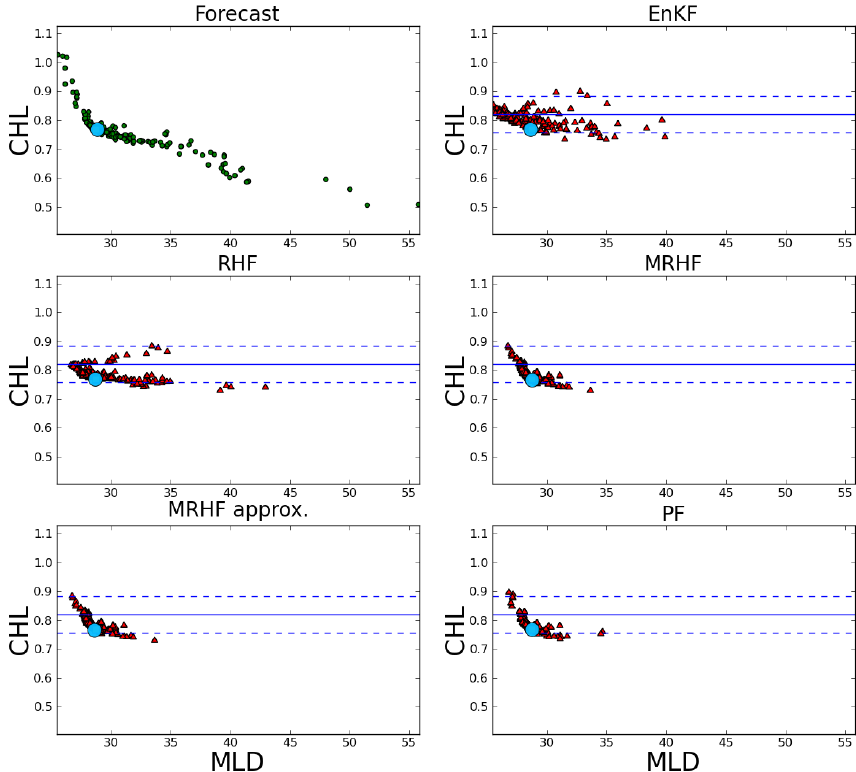
Figure 13. Prior forecast ensemble (upper left panel) and posterior analysis ensembles (red triangles), on the chlorophyll (CHL)–mixed layer depth (MLD) plane, produced by the EnKF (upper right panel), the RHF (center left panel), the full MRHF (center right panel), the mean- field approximation MRHF (bottom-left), and the SIR particle filter (bottom right panel). Only chlorophyll is observed with the value CHL o indicated by the blue line on each panel. The two dashed blue lines represent the interval [CHL o − 2 σ o , CHL o + 2 σ o ], where σ 2 o =0.001 is the observation error standard deviation. The blue dot represents the true state, from which the chlorophyll value has been extracted and perturbed to form the observation CHL o